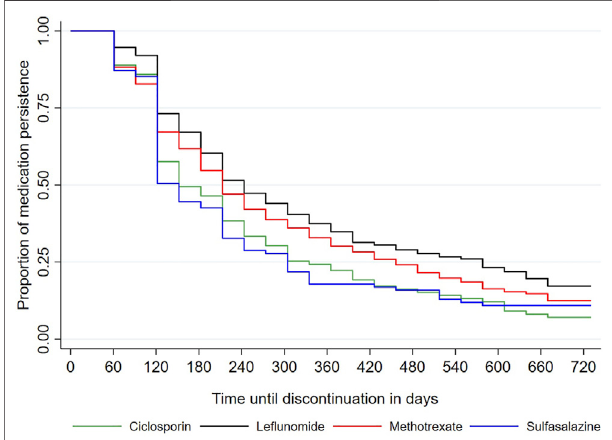
FIGURE 2 | Medication persistence of csDMARD for psoriatic arthritis.